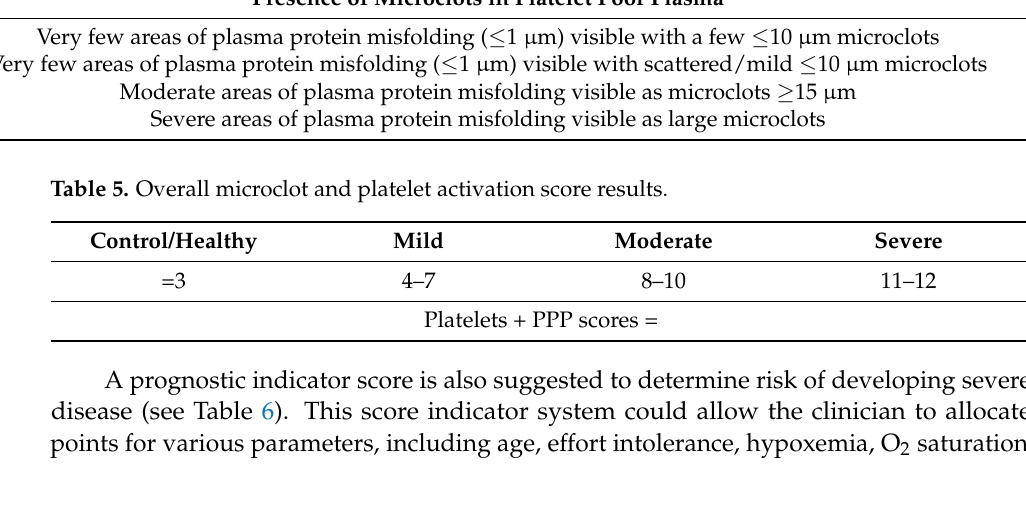
Table 4. Microclot criteria to determine the amount of microclots in the platelet poor plasma sample. Score Presence of Microclots in Platelet Poor Plasma